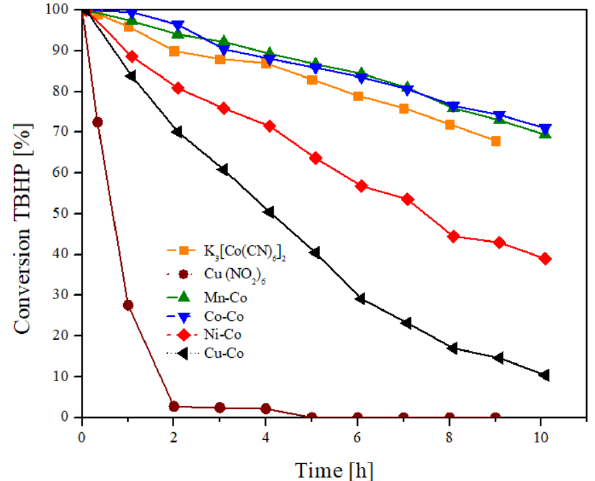
Figure 8. Oxidation effect. Exhaustion of the oxidizing agent with styrene TBHP 75 °C, in presence of catalyst. of